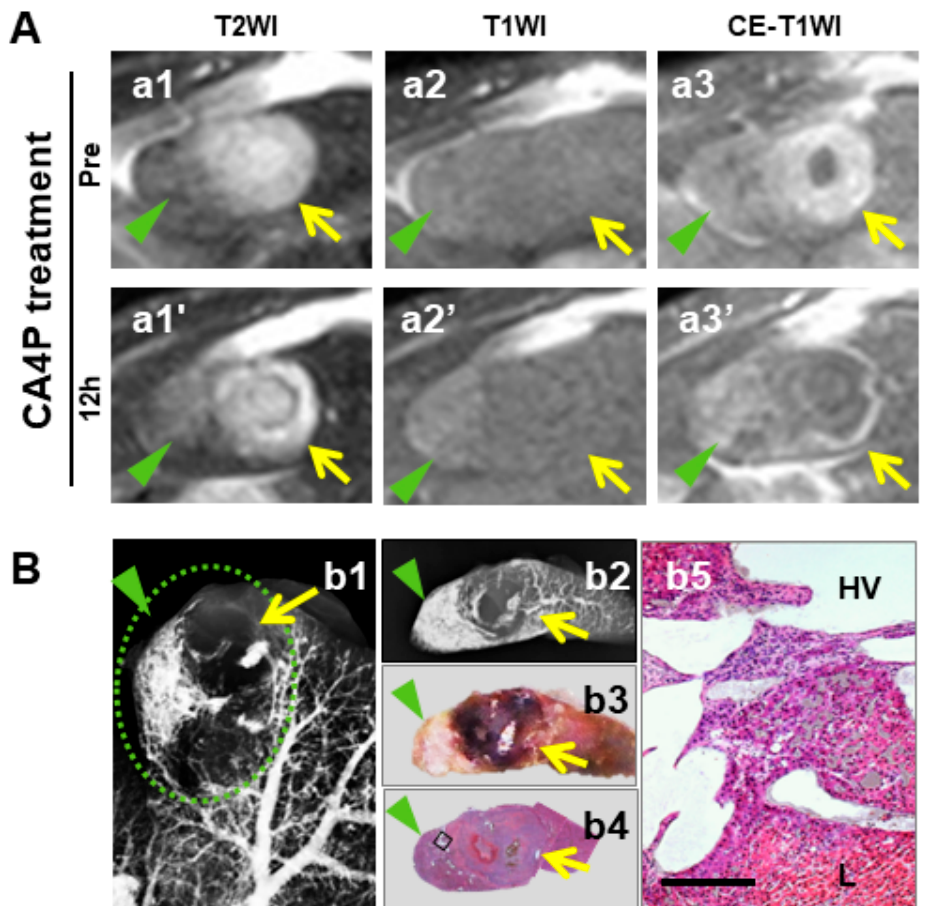
Figure 5. Identification of hepatic perfusion disorder (HPD) associated with focal liver tumor. ( A ): A wedge-shaped area (green arrowheads) peripheral to an intrahepatically implanted R1 tumor (yellow arrows) appeared on both T2WIs (a1, a1 ′ ) and T1WIs (a2 ′ , a2 ′ ), and Gd-DOTA enhanced magnetic resonance imaging (MRI) (a3–a3 ′ ) independent of CA4P treatment that caused typical MRI changes of the tumor though. ( B ): Microangiographs of corresponding liver lobe (b1) and the sliced tissue block (b2) revealed a wedge-shaped area with abundant barium suspension next to the tumor, which was in line with the corresponding photomacrograph (b3) and H&E stained photomicrographs (b4, original magnification ×12.5, scale bar = 800 μ m; b5, original magnification ×100, scale bar = 100 μ m). The findings suggest that expanded tumor compressed local hepatic vein (HV) that was dilated and filled with barium suspension, possibly responsible for this case of HPD.